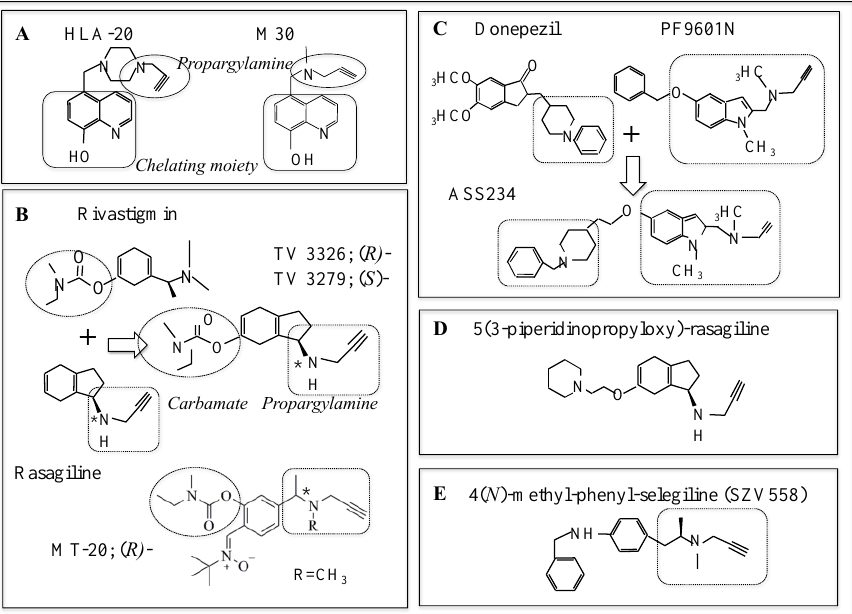
Figure 5. Chemical structure of propargylamine derivatives. ( A ) 8-Hydroxyquinone derivatives of rasagiline (HLA-20, M30) inhibit MAO-B and chelate metals. ( B ) Propargyl derivatives of rivastigmine (TV3326, TV3279) inhibit ChE and MAO-B with a carbamate moiety and exert neuroprotection by a propargylamine moiety. ( C ) Propargylamine derivatives of donepezil. ( D ) Indanone derivatives of rasagiline are H3 receptor agonists, inhibit MAO, and improve cognitive functions. ( E ) N -Methyl-phenyl-selegiline inhibits MAO-B, chelates copper (II), iron (II), and zinc (II), and inhibits A β 1-42 aggregates.